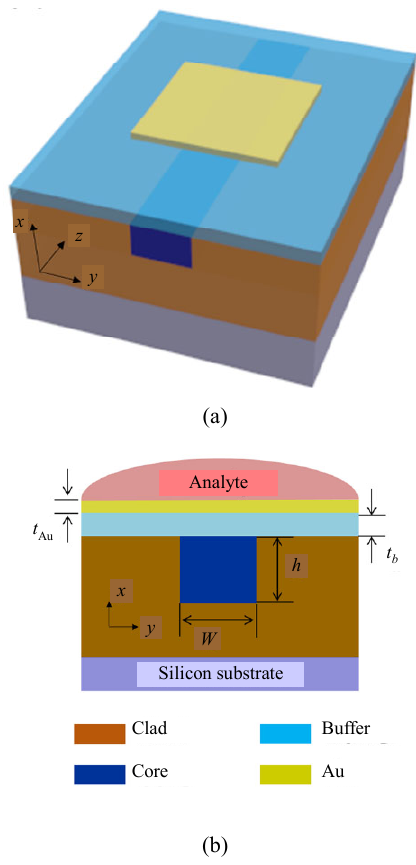
Fig. 1 Schematic diagram of (a) the 3-dimensional (3D) structure and (b) cross section of the designed RI